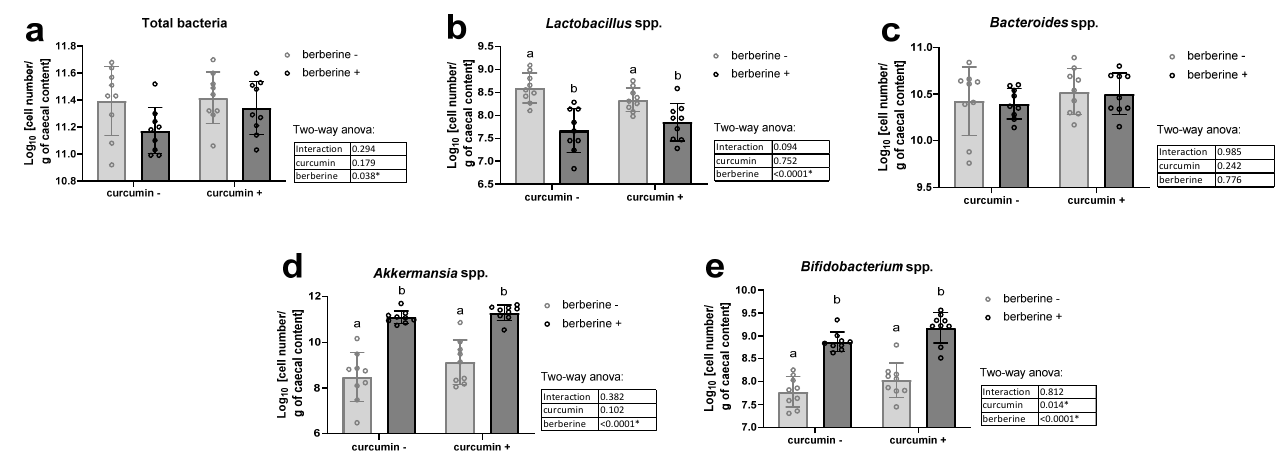
Figure 1. Bacteria in the cecal content. Ob/ob mice were fed a standard diet supplemented with or without berberine or curcumin for 4 weeks ( n = 9 for each group). qPCR analysis of total bacteria ( a ), Lactobacillus spp. ( b ), Bacteroides spp. ( c ), Akkermansia spp. ( d ) and Bifidobacterium spp. ( e ) in the caecal content. * p < 0.05 for berberine or curcumin effect (two-way ANOVA). Data with different superscript letters are significantly different at p < 0.05 (Tukey post-hoc test).